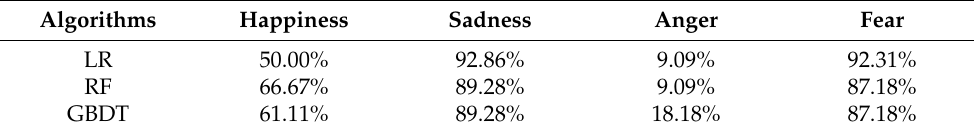
Figure 9. The classification accuracy on the test set of eight classifiers when ( a ) 15 features are selected; ( b ) 20 features are selected; ( c ) 25 features are selected; ( d ) 29 features are selected. Table 4. Accuracy of Every Emotion with LR, RF and GBDT